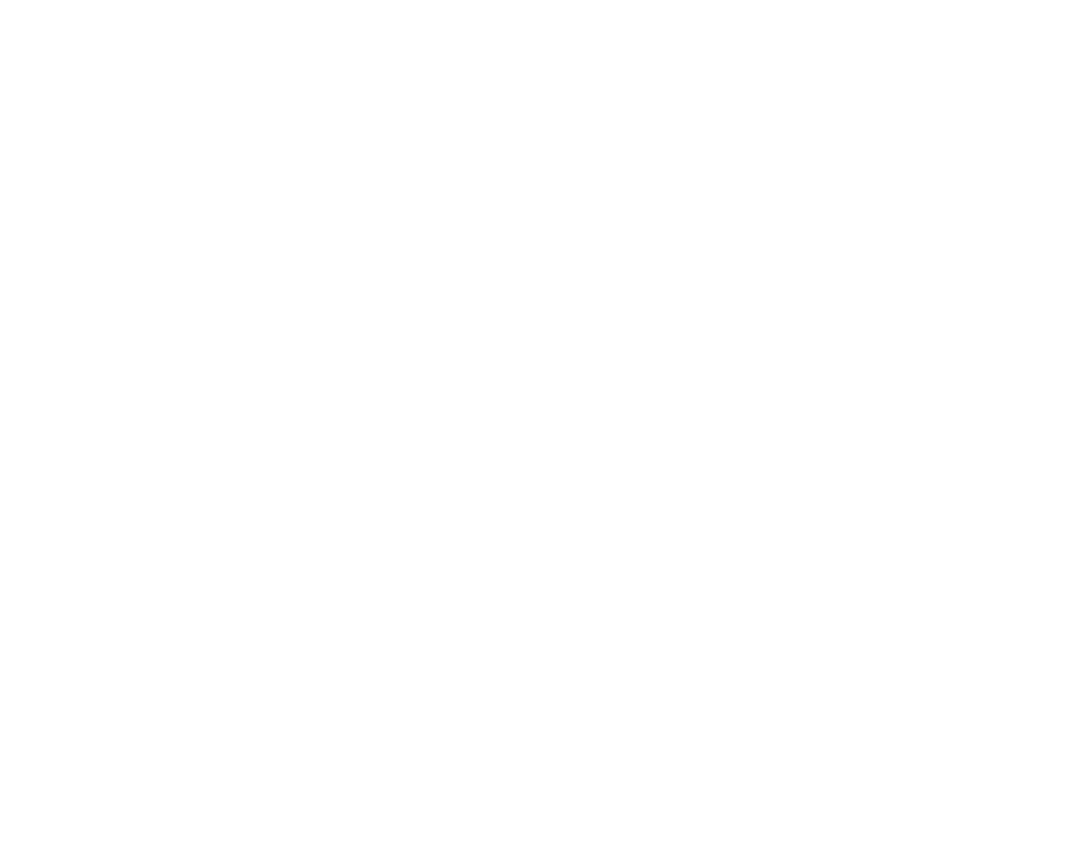
Figure 8. ( a ) Schematic illustration of separation of tiny oil-droplets from the oil-in-water emulsion, ( b ) the effect of sorbent mass on the turbidity or transparency of final filtrate solution from the hexane-in-water